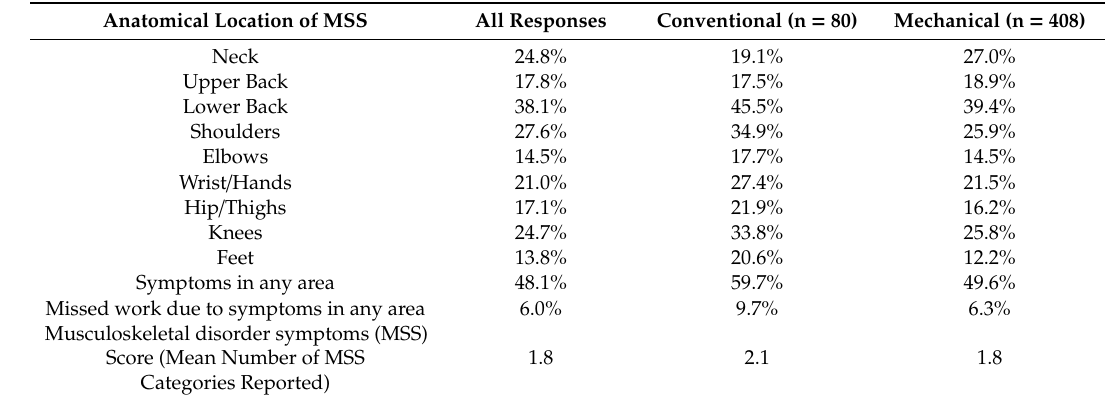
Table 3. The percentage of workers reporting musculoskeletal symptoms (one-year period prevalence): conventional vs. mechanical operations.